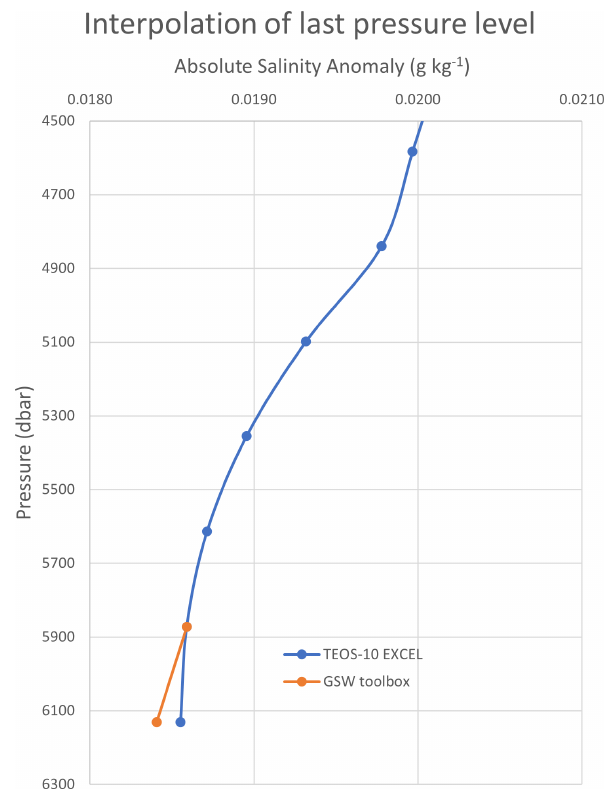
Figure 10. The δS atlas plot from the TEOS-10 Test Data tab. Not A all neighbour points have data at the last pressure level. For these points, TEOS-10 Excel uses the same value as of their last pressure level to resolve the 3D interpolation cube, while the GSW toolbox averages the same level data from neighbouring